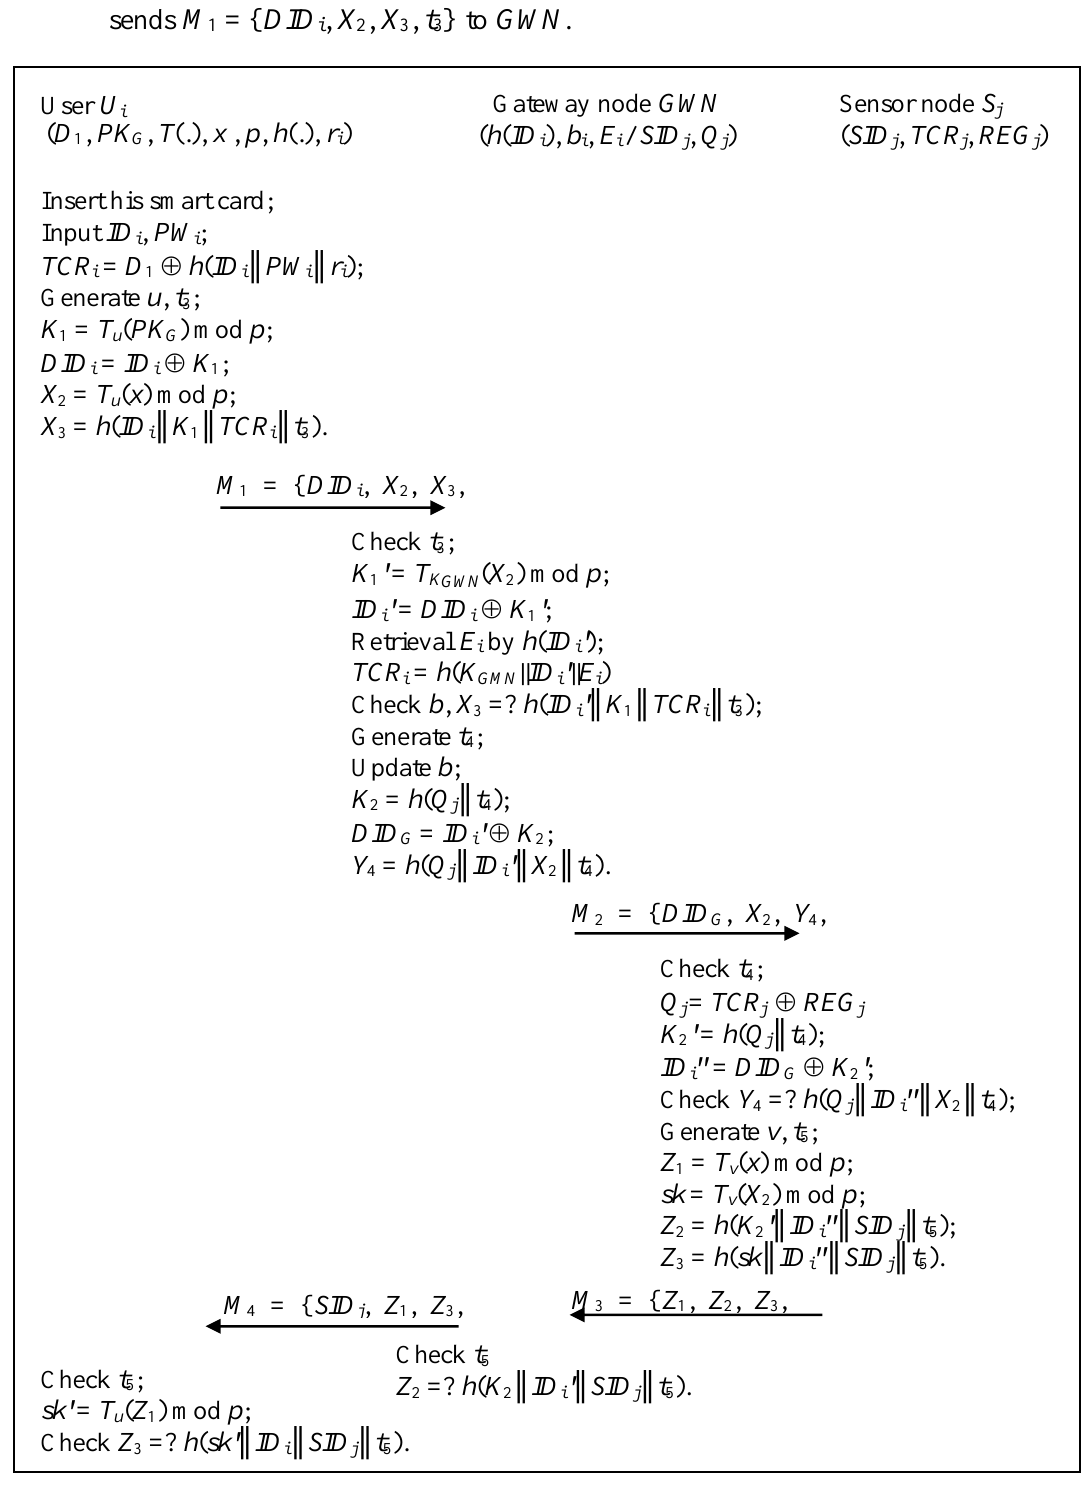
Figure 1. The login and authentication phase of the proposed scheme for